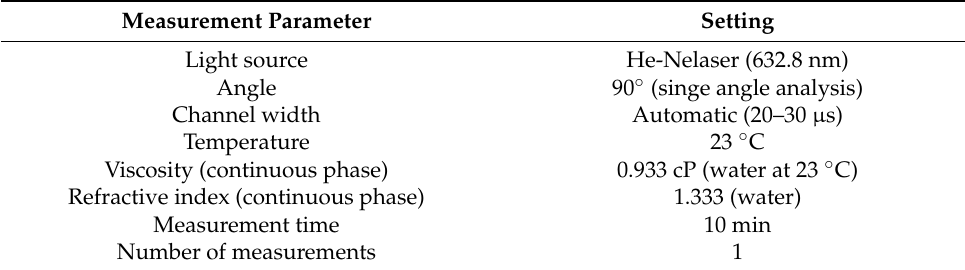
Table 2. Measurement parameters on the PCS 380 DLS Nicomb device.